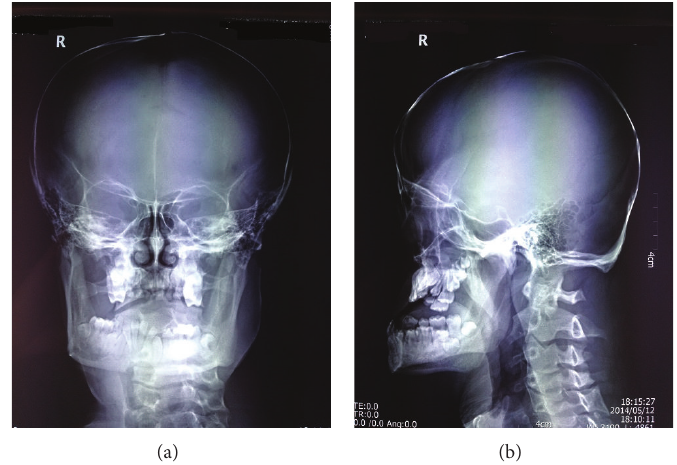
Figure 2: Head X-ray images. (a) Front head X-ray images presented that his teeth were sparse and irregular. Part of the permanent teeth was absent on the hypoplastic upper alveolar ridge; (b) lateral head X-ray images show that the upper alveolar ridge was depressed and lower alveolar ridge was